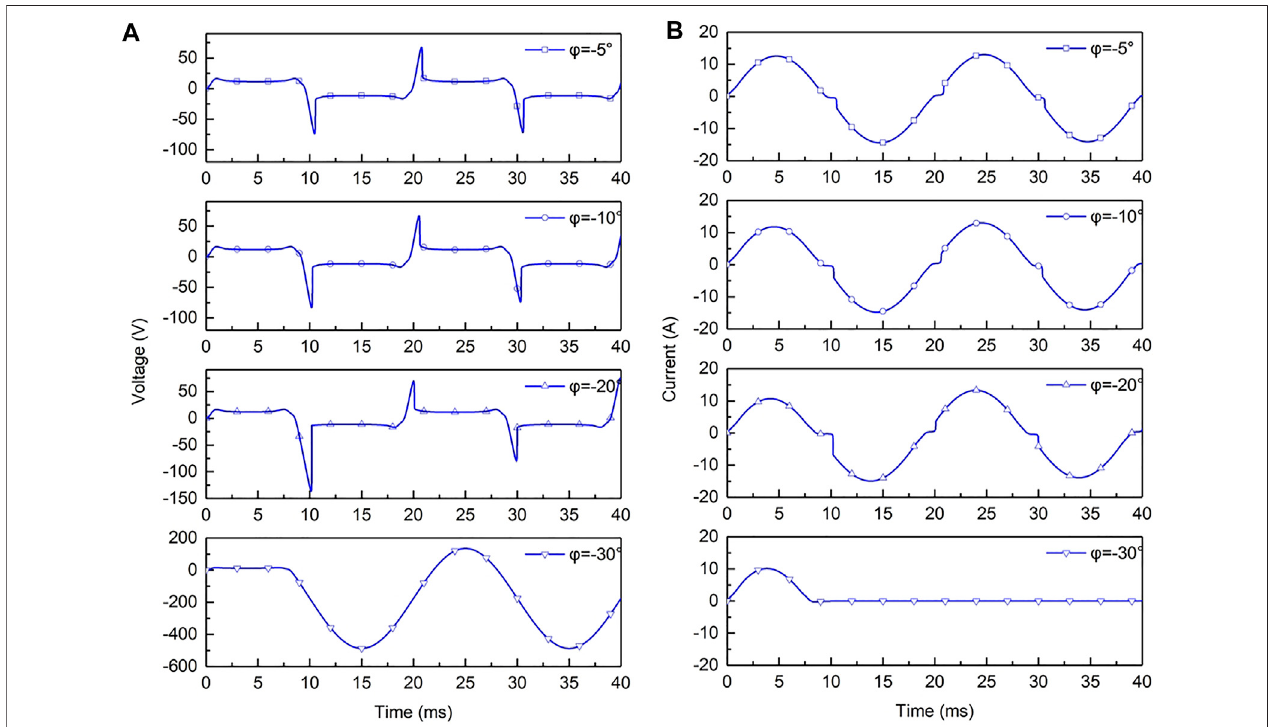
FIGURE 13 | Resistive capacitive load (A) voltage and (B)